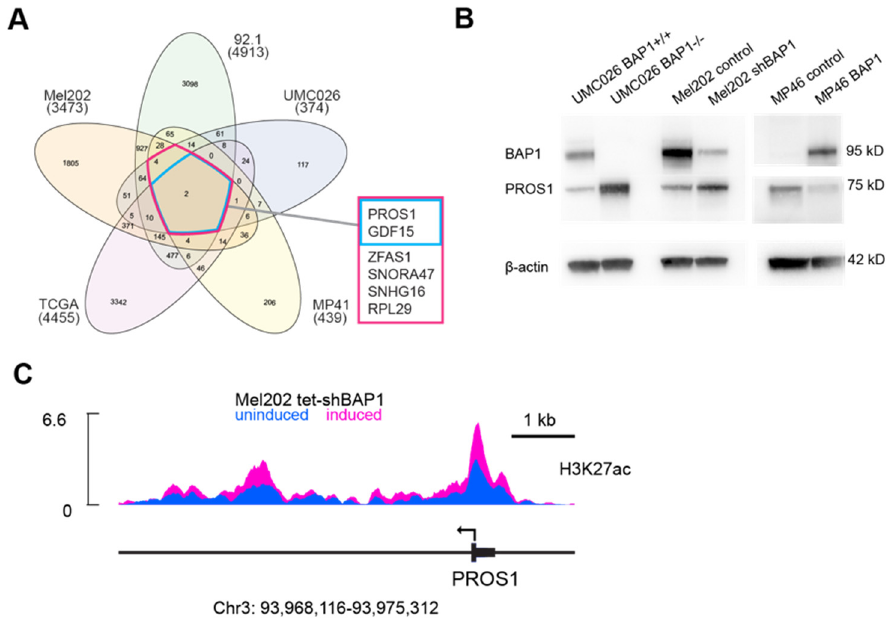
Figure 1. PROS1 expression is regulated by BAP1 in uveal melanocytes and uveal melanoma cells. ( A ) Summary of RNA sequencing data from BAP1-wildtype Mel202, 92.1, and MP41 uveal melanoma cells, and UMC026 uveal melanocytes with or without shRNA-mediated knockdown of BAP1, and 80 UM samples from The Cancer Genome Atlas (TCGA) data repository with or without mutational inactivation of BAP1. Numbers in parenthesis indicate the number of genes upregulated by loss of BAP1. Numbers within the Venn diagram indicate the number of overlapping genes between indicated subsets of genes. PROS1 was one of only two genes that was upregulated across all datasets. ( B ) Immunoblots confirming upregulation of PROS1 protein following knockout of BAP1 in UMC026 cells, or knockdown of BAP1 in Mel202 cells. Conversely, ectopic expression of BAP1 in MP46 BAP1-mutant class 2 uveal melanoma cells resulted in downregulation of PROS1. PROS1/ β - actin densitometry ratios (lanes 1–6): 0.29592, 1.2059, 0.61066, 1.1644, 0.34334, 0.10613 ( C ) ChIP-seq analysis of H3K27ac at the PROS1 locus in Mel202 cells with or without doxycycline-induced, shRNA- mediated knockdown of